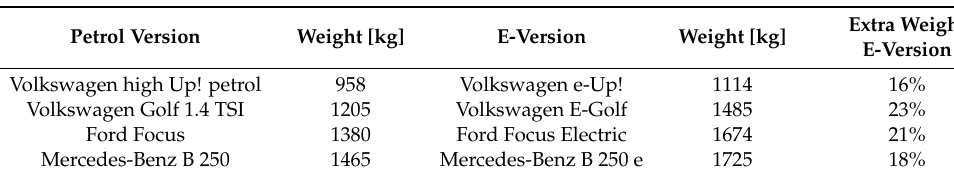
Table 16. Weight of Internal Combustion Engine (ICE)-cars compared to the electric version. The weight of the petrol car includes a half full tank.